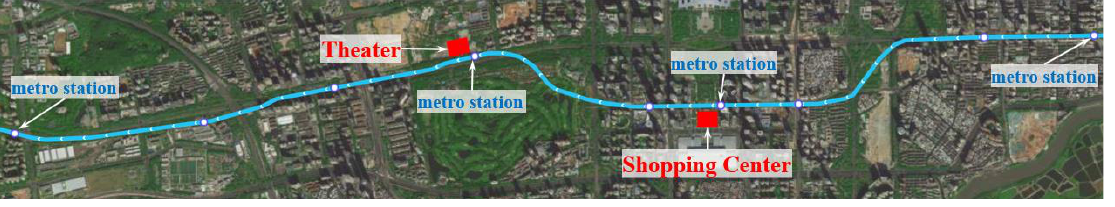
Figure 10. Route map of Metro Line A.